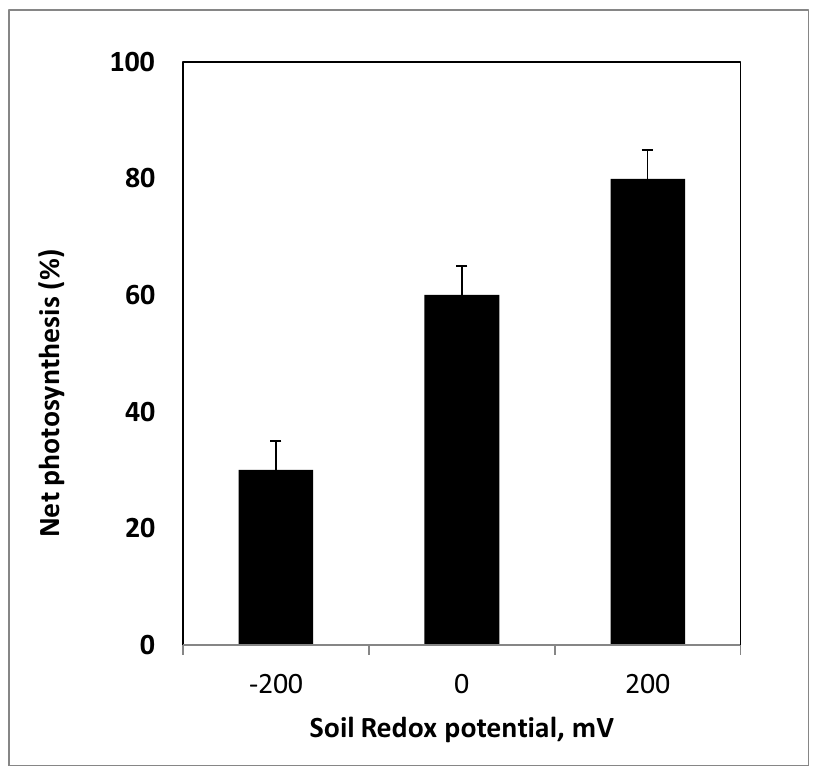
Figure 4. Changes in net photosynthesis of Typha domingensis in response to soil redox conditions. Values are presented as percent of controls (from Pezeshki et al . [157]).